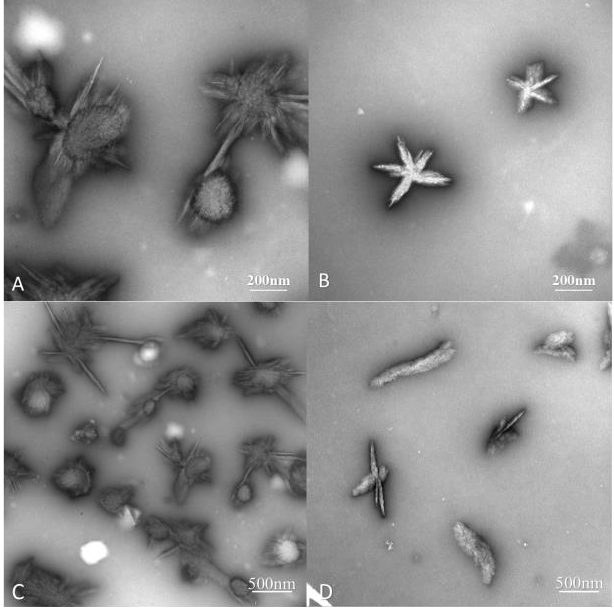
Figure 4. Transmission electron microscope (TEM) image of CUR-PC ( A , C ) and CUR ( B , D ).